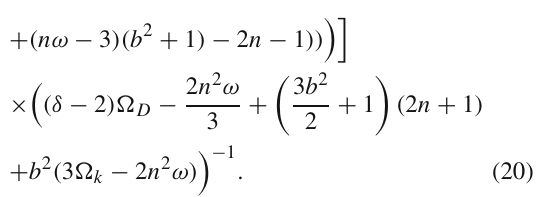
Fig. 4 The evolution of (cid:3) D versus z for the interacting THDE in the BD gravity. Here, we considered (cid:3) k = 0 (upper panel), (cid:3) k 0 = 0 . 1 (lower panel), (cid:3) D 0 = 0 . 73, n = 0 . 005 and ω = 10000 [20] for the initial